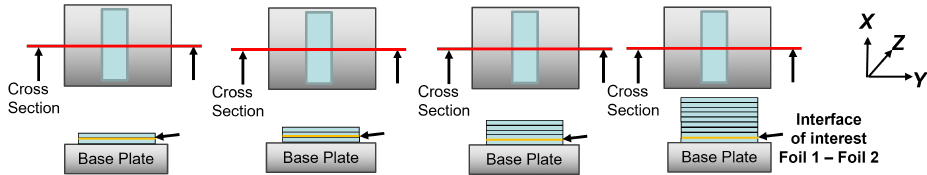
Figure 5. Samples fabricated with 2, 3, 5, and 10 layers of Al 6061-H18 foil UAM welded on a 12.7 mm (0.5 inch) thick Al 6061-T6 baseplate to study the effect of subsequent weld layers on the weld interface